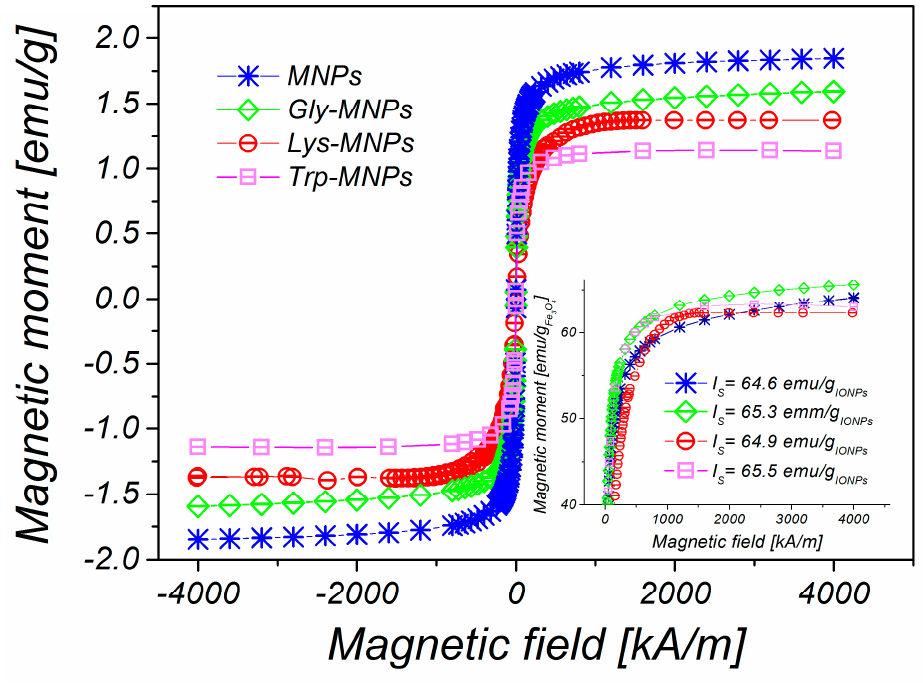
Figure 3. Magnetisation curves of uncoated MNPs, Gly-, Lys- and Trp-magnetic nanoparticles (MNPs) with concentration c = 25 mg iron oxide nanoparticles (IONPs)/mL. Inset: recalculated saturation magnetization of the samples on emu/g IONPs .